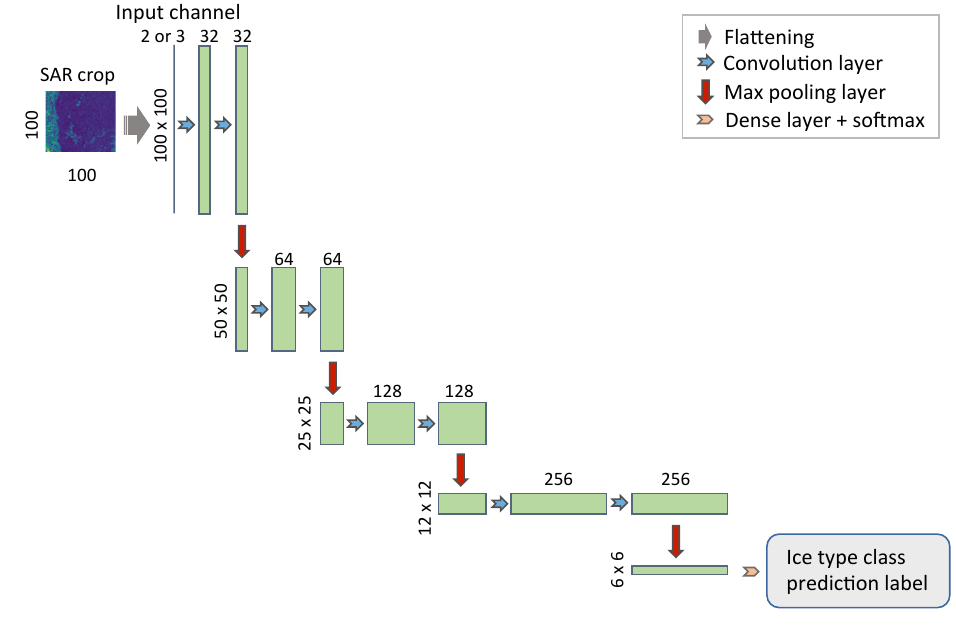
Figure 3. U-Net based model: The model consists of the encoder (down-sampling) portion of a U-Net model that maps a SAR sub-image to a prediction label. A representative model used in this work consists of approximately 1.2 million